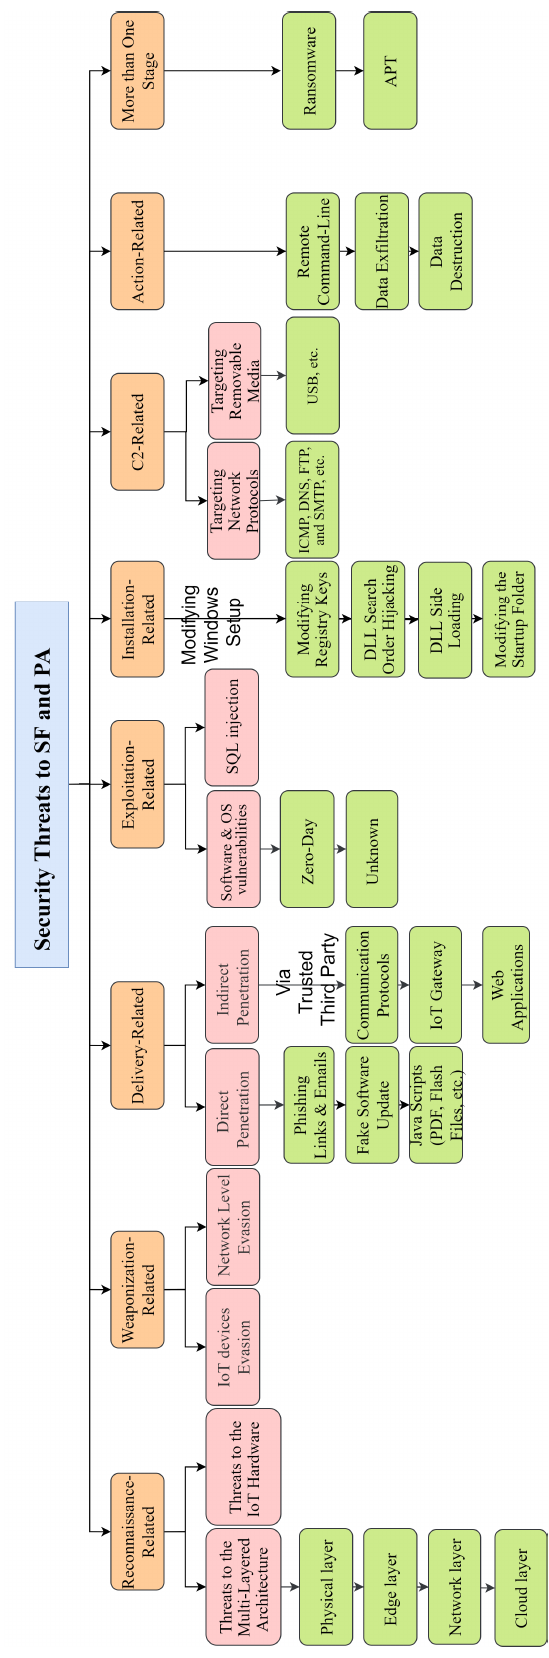
Figure 4. The CKC-based taxonomy on cyber-threats to SF and